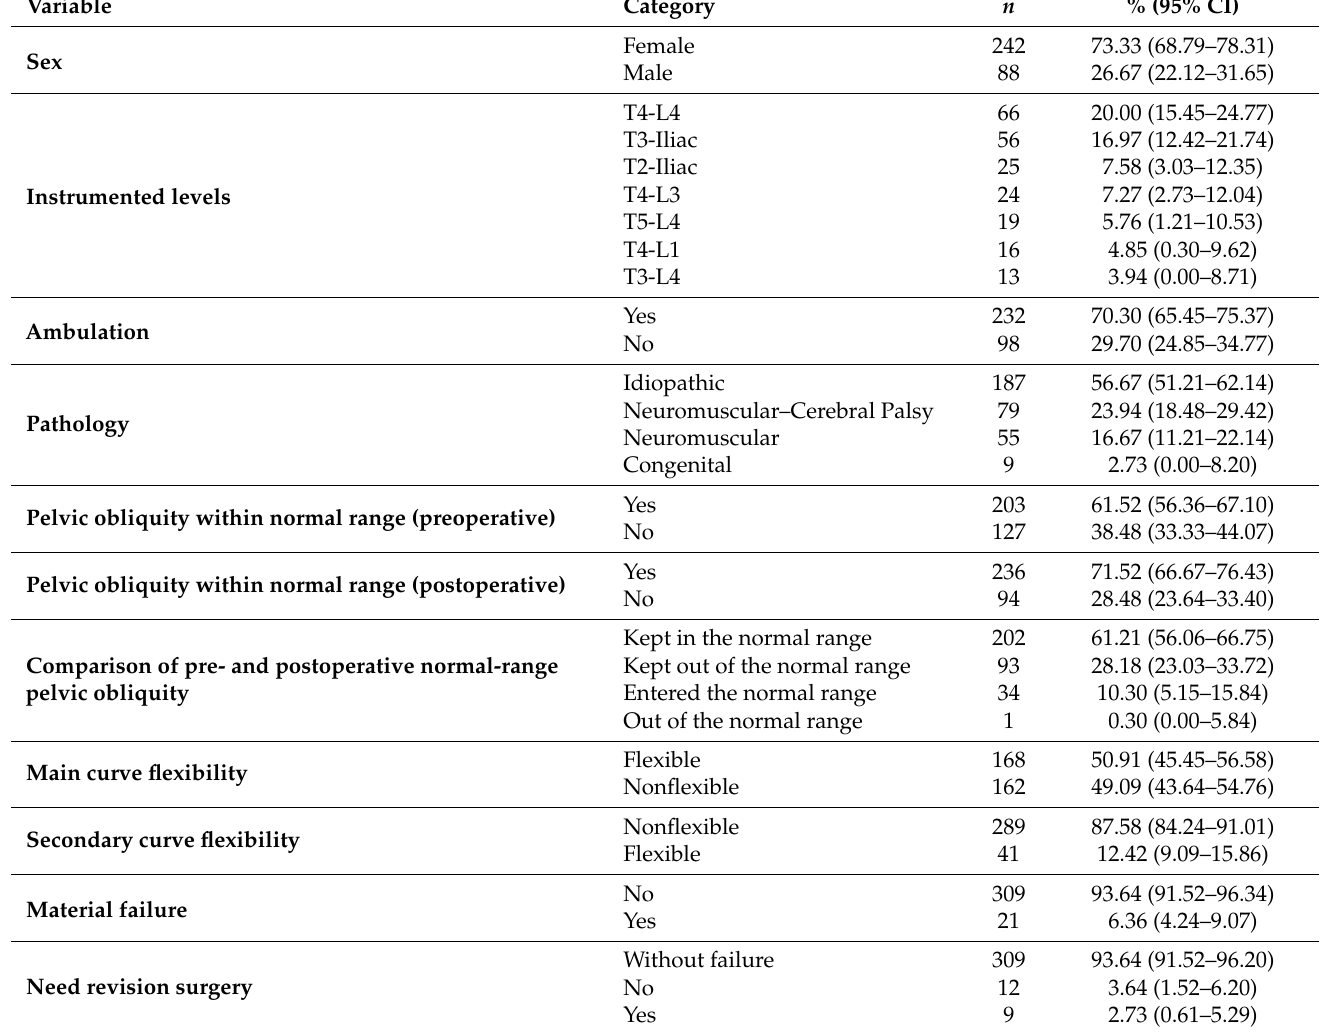
Table 1. Descriptive statistics of qualitative